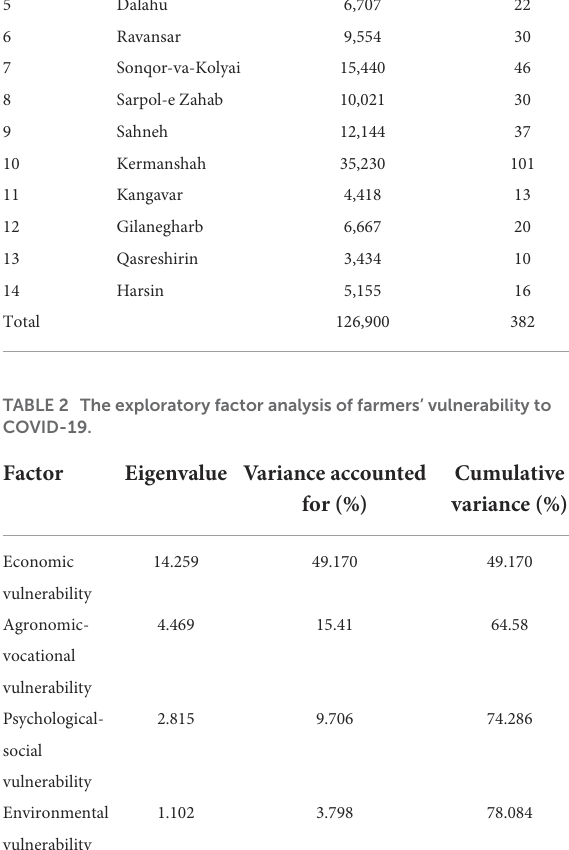
TABLE 1 The statistical population and sample sizes of different counties. Sr. No.